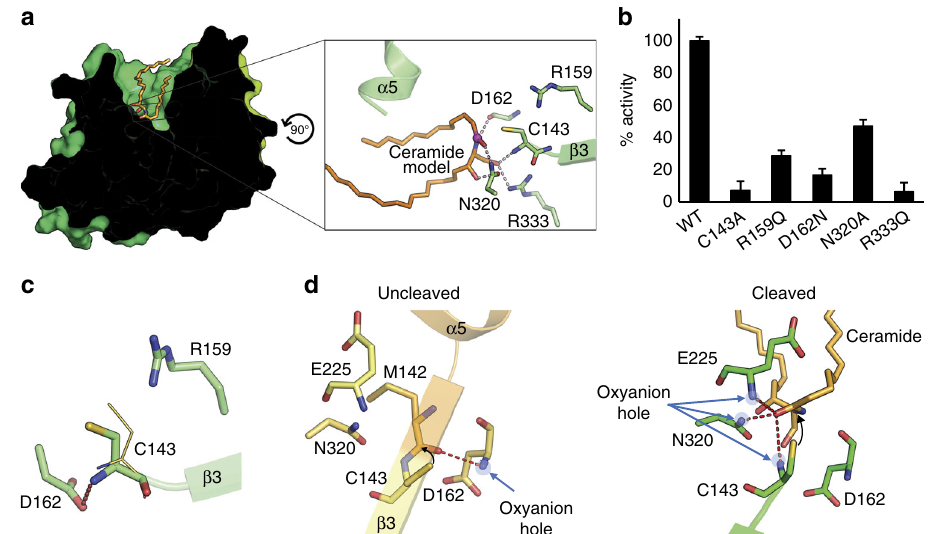
Fig. 4 The active state of aCDase. a Docking of C12 ceramide into the active site of aCDase. Left, surface representation of the active human enzyme with the docked ceramide shown as orange sticks. The box on the surface is shown zoomed in the right panel. Right, shown are active site residues (green sticks) that make potential interactions (dashed pink lines) with the modeled ceramide. The carbonyl carbon in ceramide attacked by Cys 143 is highlighted as a purple sphere. Hydrogen bonds within the protein active site are omitted for clarity. b Ceramidase activity of the active site mutants of aCDase on ceramide-containing anionic liposomes at pH 4 in the presence of the co-factor saposin-D. One hundred percent activity for wild-type enzyme corresponds to 0.54 μ M ceramide hydrolyzed per nM protein per hour. Data are the means and s.d. ’ s of eight replicates. c Shift in position of Cys 143 upon activation. The position of the modeled Cys 143 rotamer from the inactive state is shown as a thin yellow stick. Residues in the active structure are shown as green sticks. Asp 162, which was further away from the Cys 143 backbone amide in the inactive state, is closer in the active state to form a weak salt-bridge (red dashes, 3.4 Å). Conversely, Arg 159 no longer forms a hydrogen bond with Cys 143 in the active state. d Comparison of the direction of the nucleophilic attack by Cys 143 on the target amide during autocleavage versus substrate hydrolysis. The two views are in roughly the same orientation. The interaction of the scissile peptide carbonyl oxygen with potential oxyanion hole residues in the respective states are indicated (dashed red